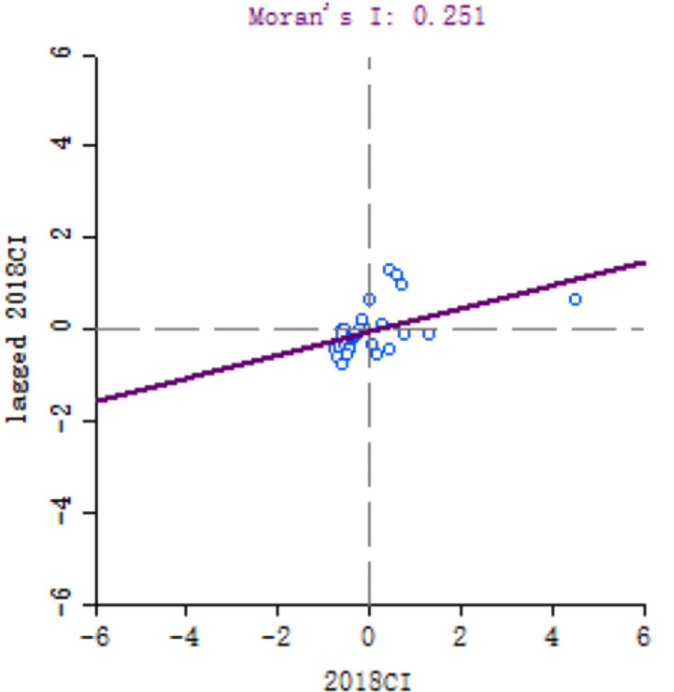
Fig 8. Moran scatter chart of industrial high quality development level in